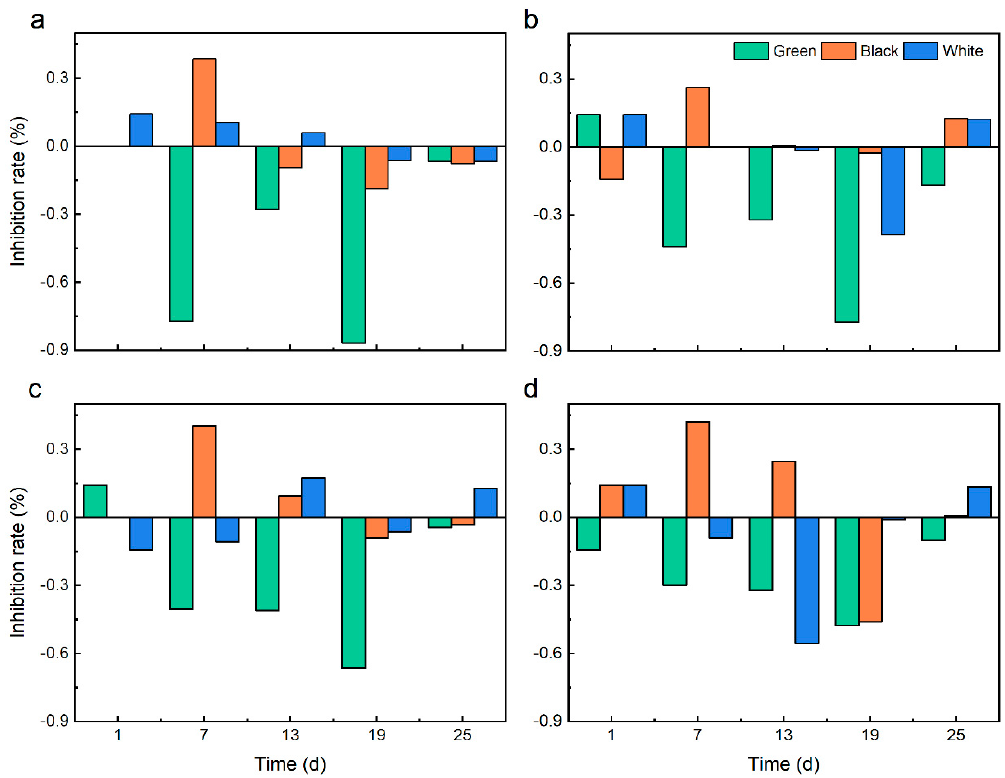
Figure A1. IR of M. aeruginosa under PET microplastic at different concentrations (( a ), 10 mg/L; ( b ), 50 mg/L; ( c ), 100 mg/L; ( d ), 200 mg/L) with time.